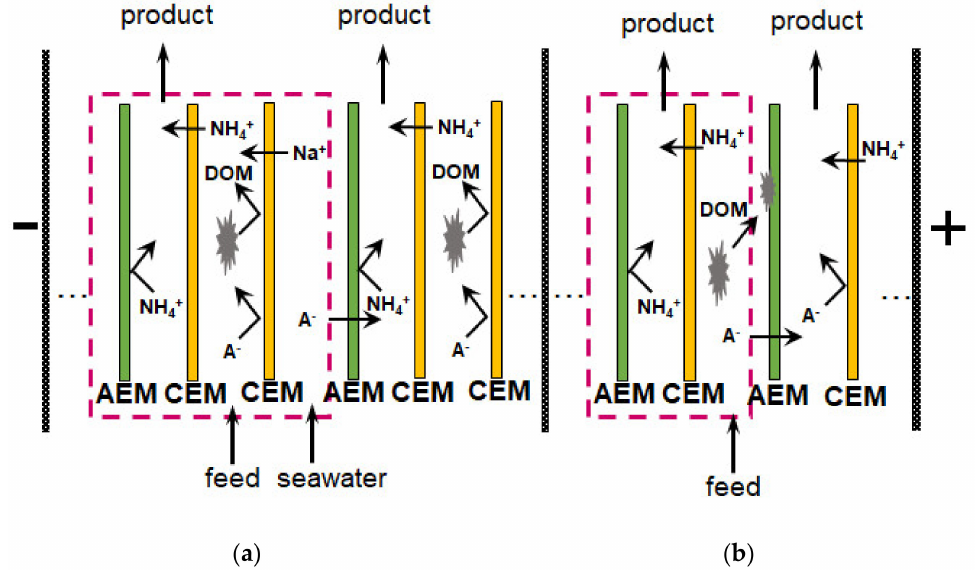
Figure 26. ED with additional CEM, which prevent the fouling of AEM by dissolved organic matter (DOM) ( a ) and conventional ED ( b ). Based on